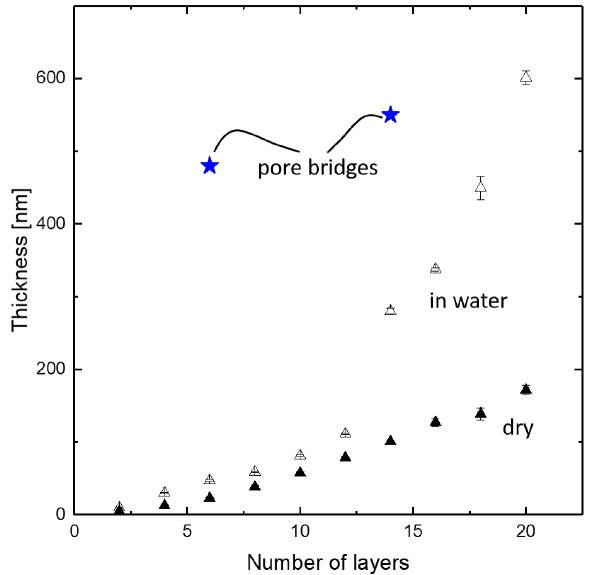
Figure 9. PDADMAC/PSS layer thickness on silicon wafers in function of number of coating steps measured by ellipsometry (triangles) in aqueous environment and air-dried as well as pore-bridging layer thicknesses taken from Figure